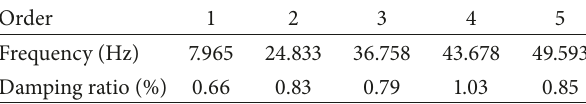
Table 3: Identified mode frequencies and damping ratios. Order 1 2 3 4 5 Frequency (Hz) Damping ratio (%)